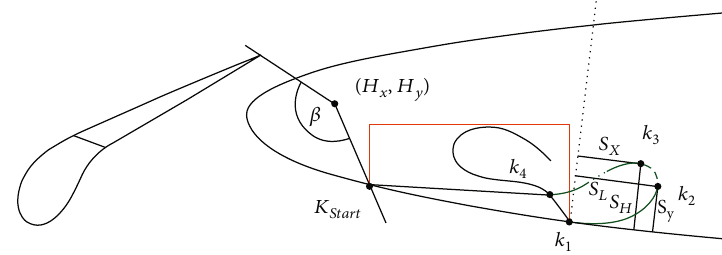
Figure 21: The design parameters of Krueger fl aps.